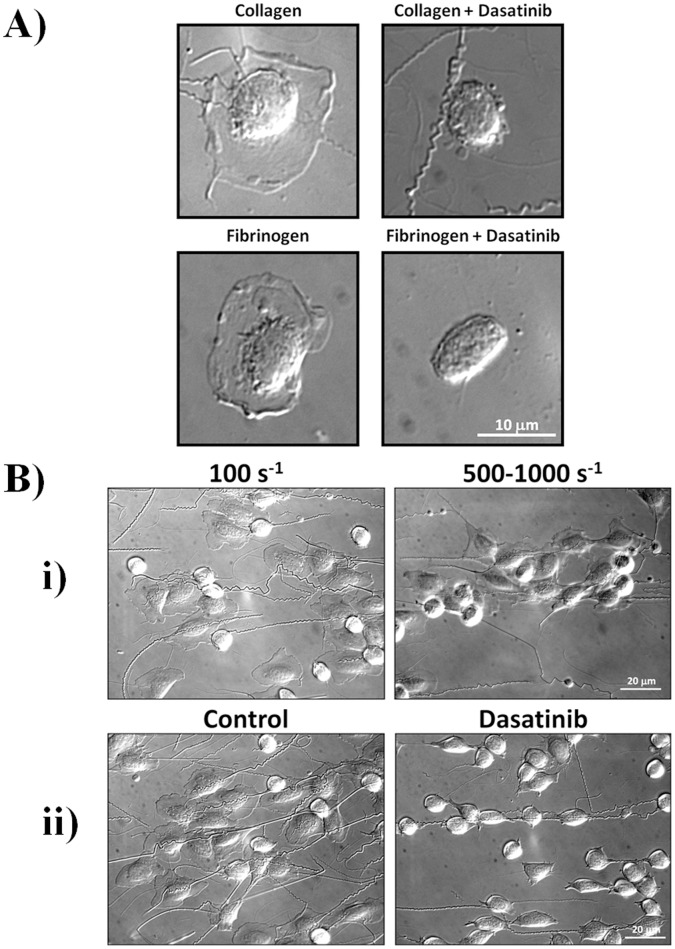
Trout thrombocytes adhere to and spread on collagen in a Src dependent manner.A) Trout blood was diluted by a factor of 100 to reduce the number of cells, and then allowed to adhere to either collagen or fibrinogen coated coverslips for 90 min at room temperature, either in the presence of 20 µM dasatinib or DMSO vehicle control. B) Anticoagulated whole blood was flowed through collagen coated glass capillary tubes at a range of shear rates (i) or at 100 s−1 for inhibitor studies (ii). Blood was pre-treated with either 20 µM dasatinib or DMSO vehicle control.